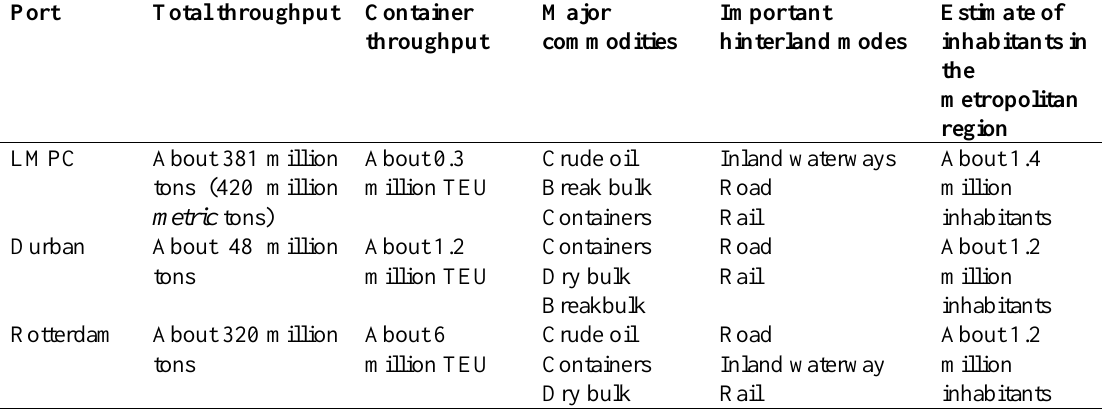
Major Important Estimate of throughput commodities hinterland modes the